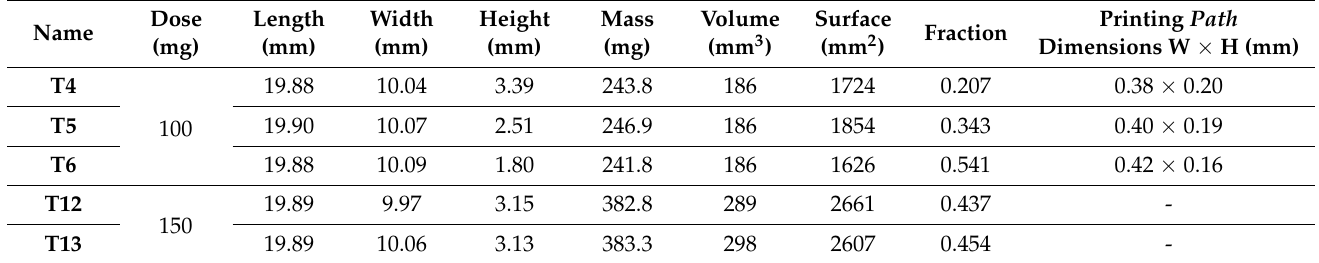
Table 3. The properties of tablets analyzed with microCT.